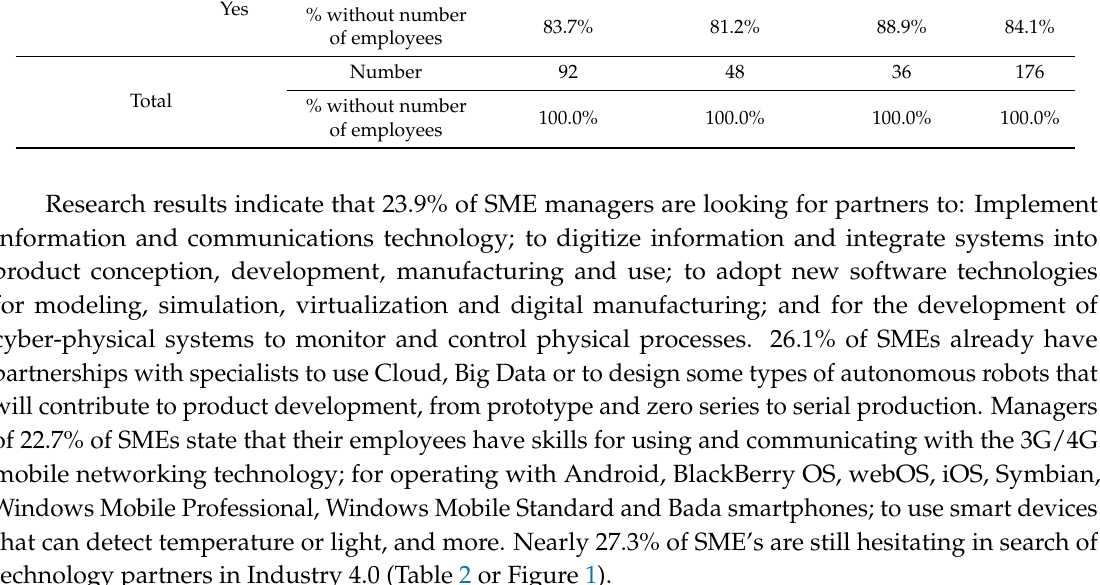
Number of Employees TotalBetween 0 and 9